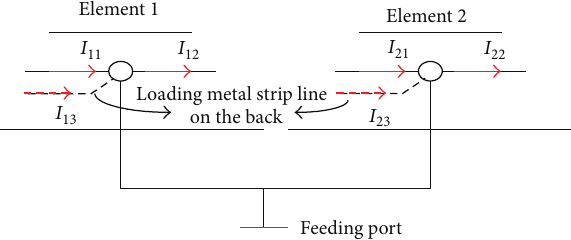
Figure 3: A diagram of the surface current on active dipoles and loading metal